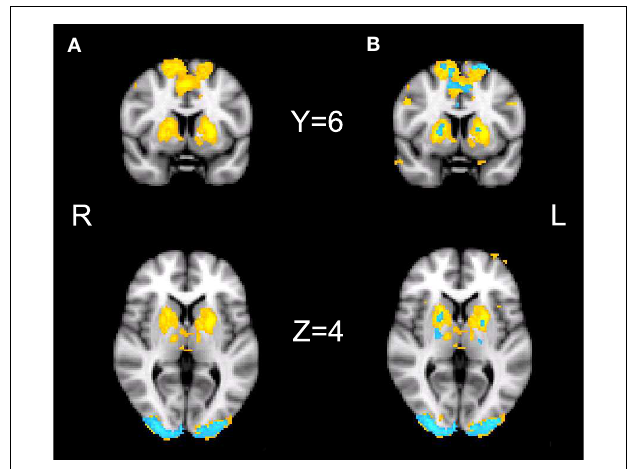
FIGURE 4 | fMRI results. Results of the fMRI analyses showing the speed–accuracy contrast during placebo (yellow) and during drug (blue). (A) Cluster thresholded with a voxel thresholded of Z = 2.3, and a cluster threshold of p = 0.05. (B) Voxel thresholded results, with a voxel threshold of Z = 2.3 and no cluster threshold.The statistical maps are overlaid on Montreal Neurological Institute (MNI)T1 anatomical scans with a 2mm